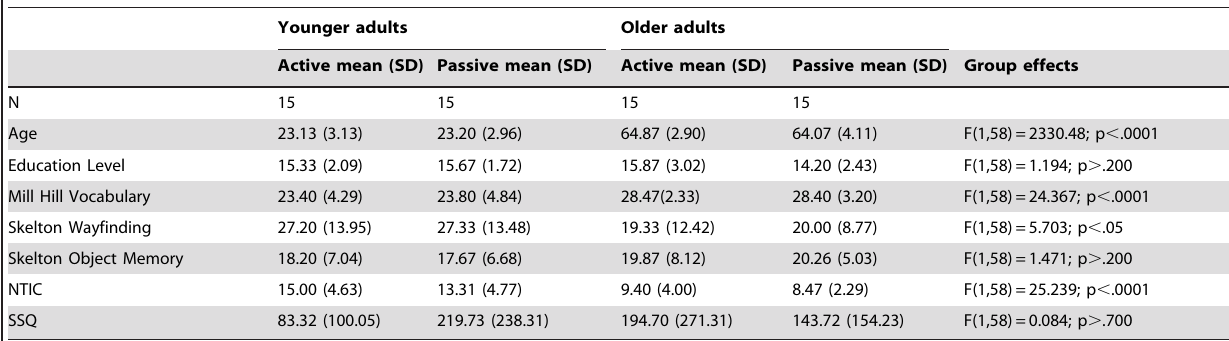
Table 1. Characteristics of the participants.